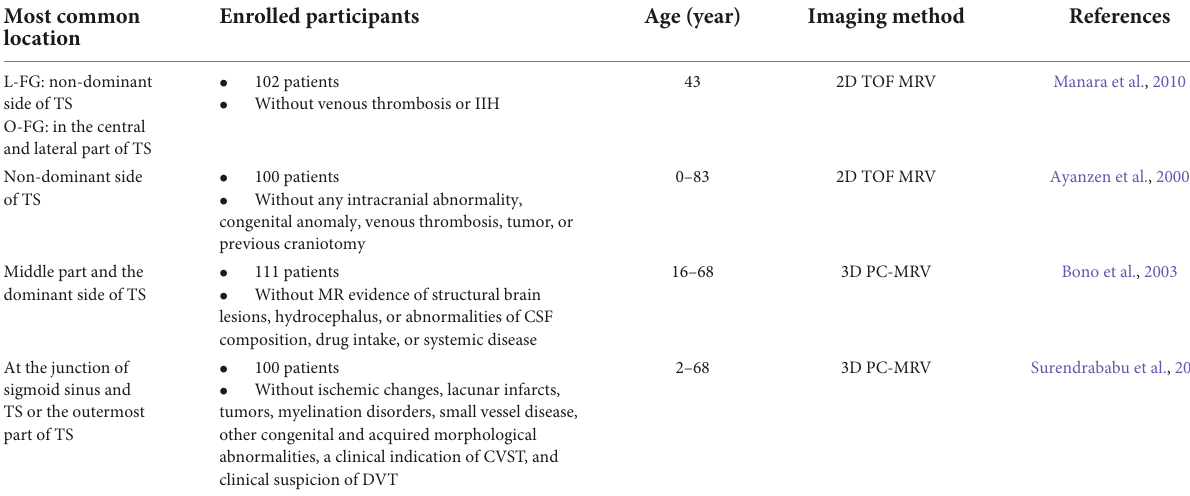
TABLE 3 Imaging characteristics of flow gaps.